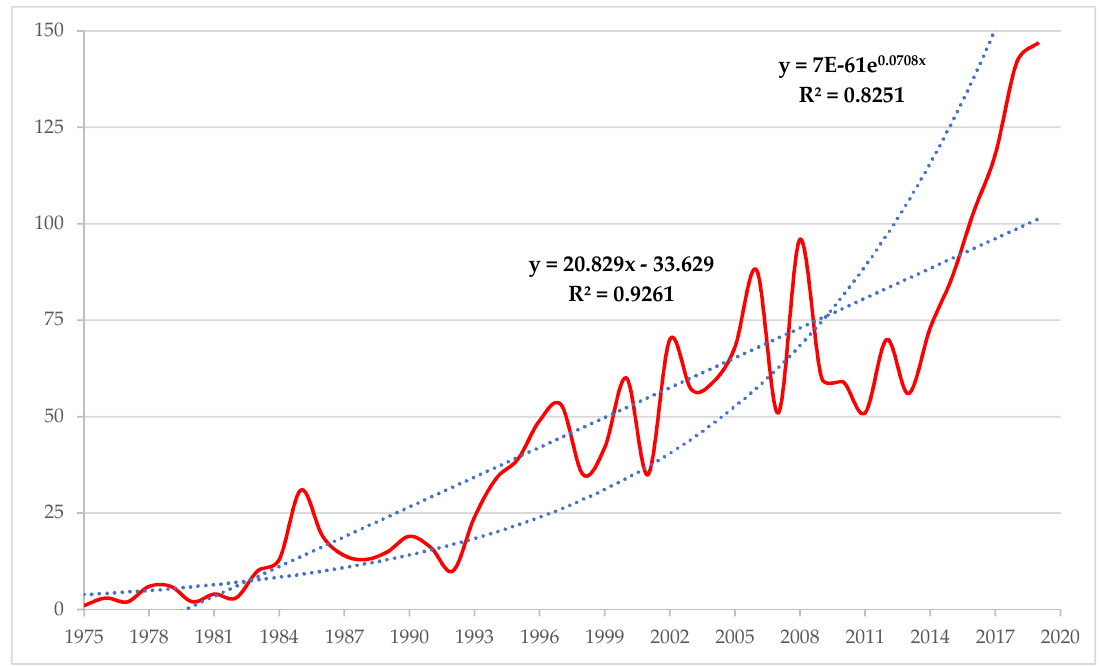
Figure 2. Evolution of the number of articles (1975–2019).